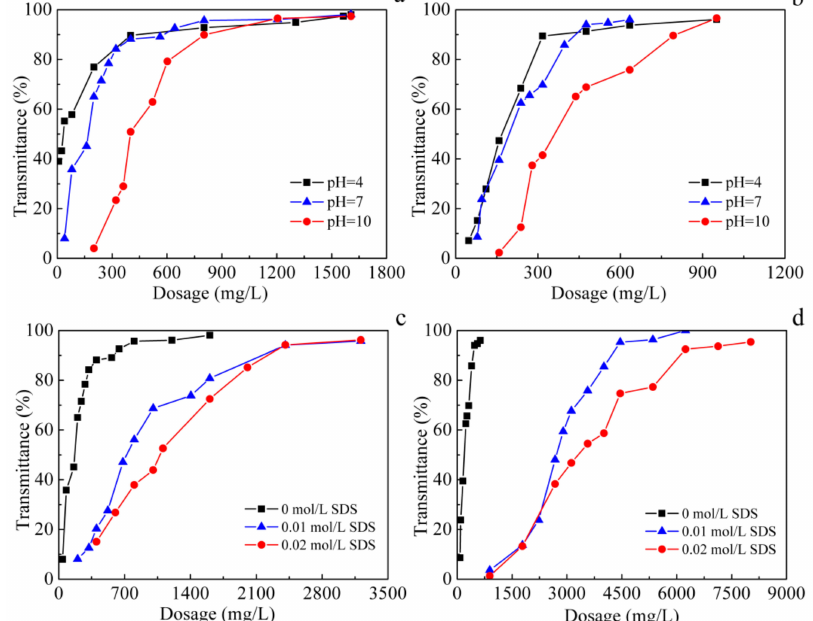
Figure 5. Demulsification e ff ect of MNPs (S1) at various pH levels in diesel oil-in-water emulsion ( a ) and soybean oil-in-water emulsion ( b ); demulsification e ff ect of MNPs (S1) at various SDS concentrations in diesel oil-in-water emulsion ( c ) and soybean oil-in-water emulsion ( d